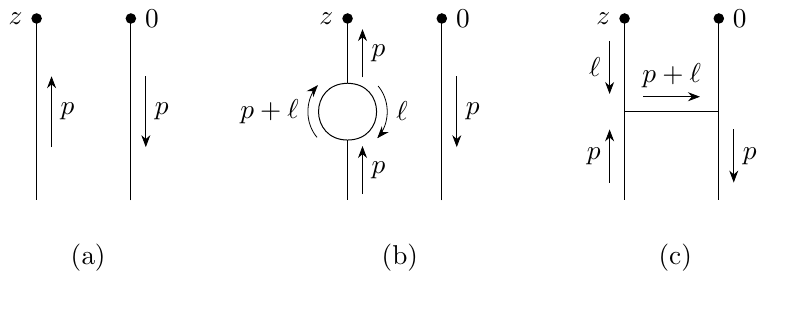
Figure 2 . Feynman diagrams up to one loop for h 0 j T [ (cid:30) ( z ) (cid:30) (0) (cid:30) ( z 1 ) (cid:30) ( z 2 )] j 0 i